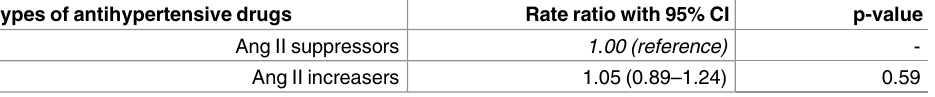
Table 3. Association between types of antihypertensive drugs and ischemic stroke severity(Score in count measure). * † Types of antihypertensive